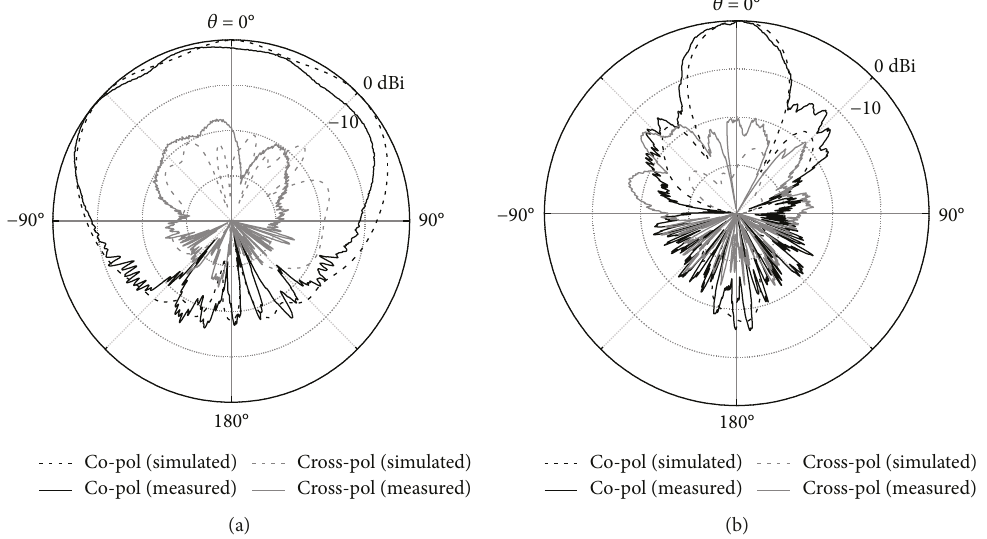
Figure 7: Simulated and measured normalized radiation patterns of the proposed SIDRAA at 34.5GHz. (a) E(yz) -plane and (b) H(xz) -plane.